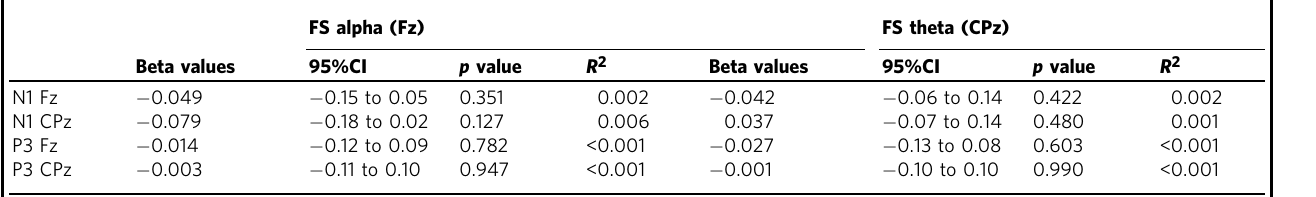
The correlations between FS (both alpha on Fz and theta on CPz) and the amplitudes in the ERPs (N1 and P3 on both Fz and CPz) were estimated. No statistical signi fi cance was found. Note. FS: frequency sliding; ERP: event-related